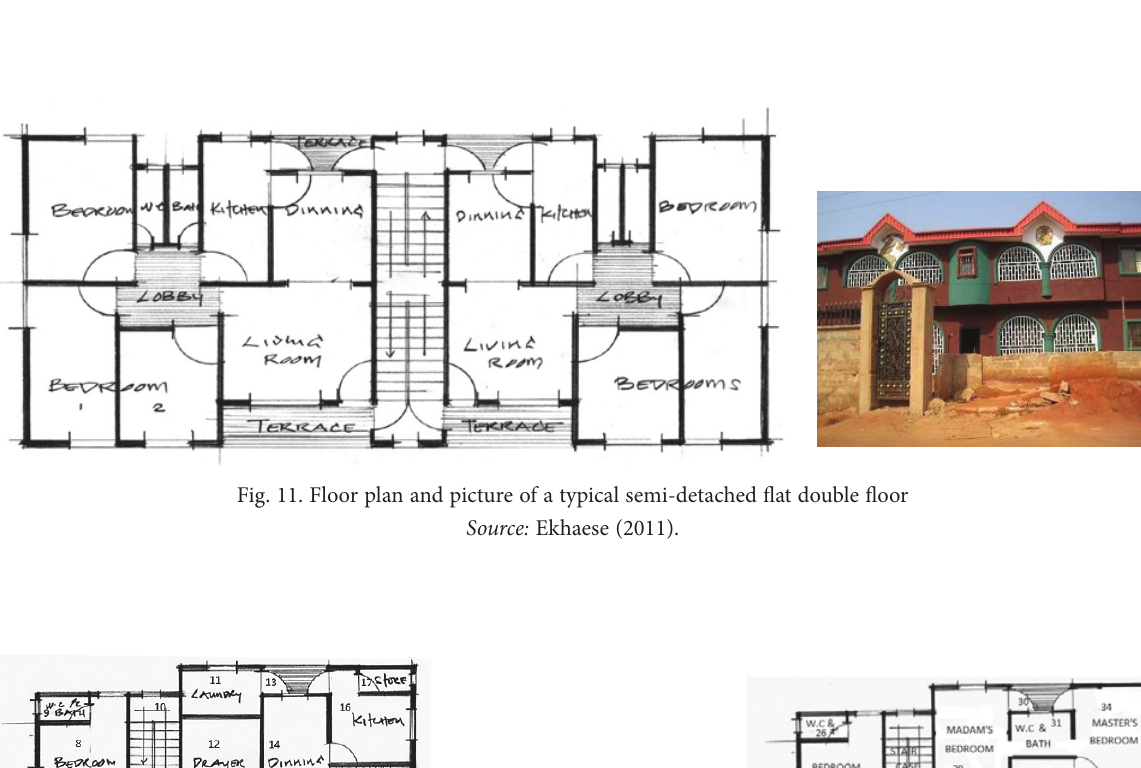
Fig. 10. Floor plan and picture of a semi-detached flat single floor house Source: Ekhaese (2011).